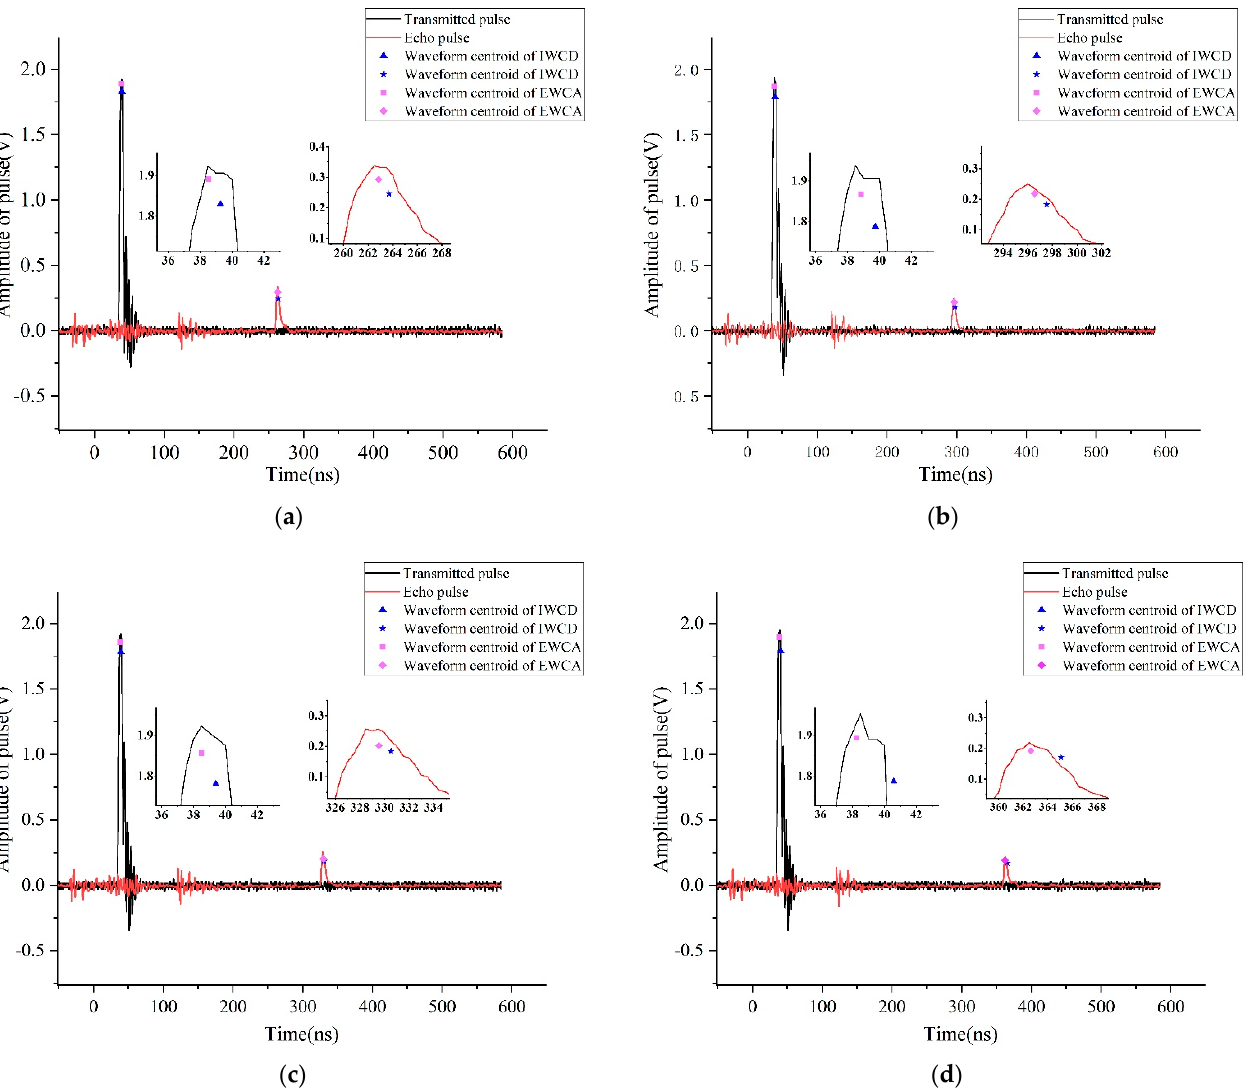
Figure 6. The calculated centroid points of the transmitted and the echo pulses: ( a ) measure the target distance at 25 m ( b ) measure the target distance at 30 m ( c ) measure the target distance at 35 m ( d ) measure the target distance at 40 m.